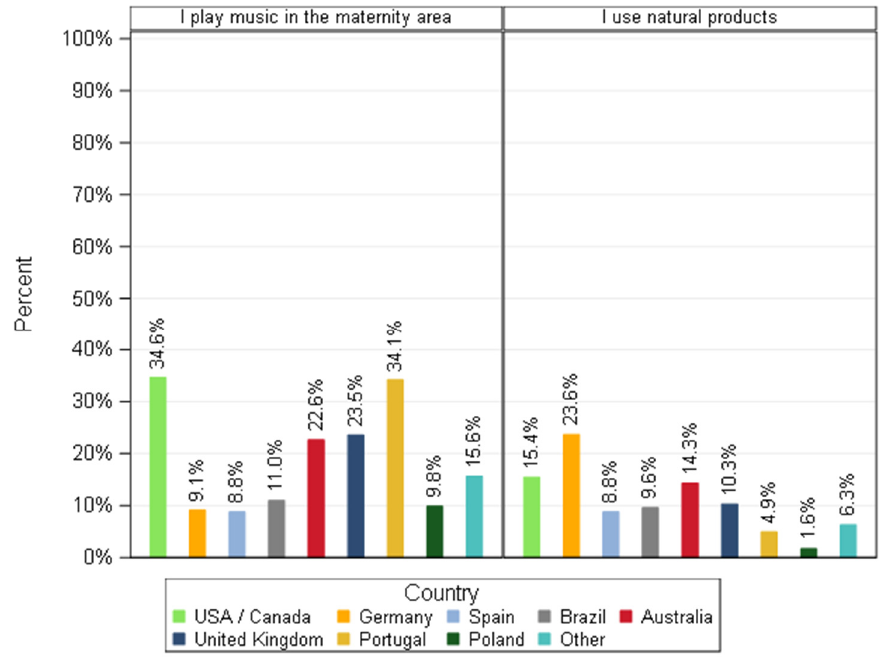
Figure 15. Percentage of dog breeders that use music and natural products as an intervention to reduce stress before/during whelping by country—responders stating to intervene ( n = 618).